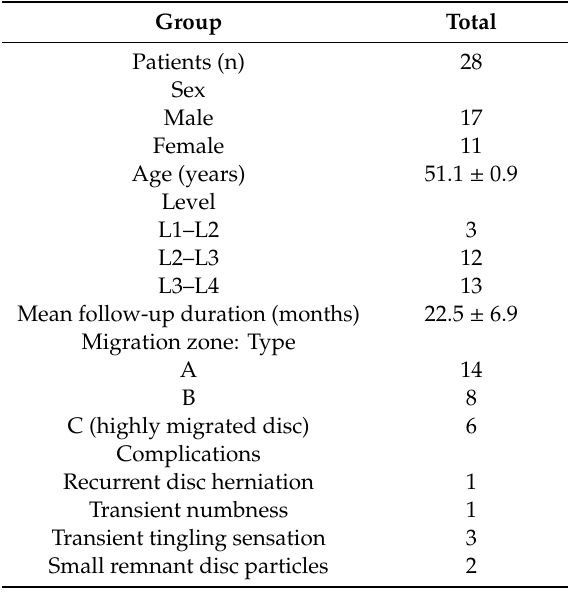
Table 1. Demographic characteristics of 28 patients.